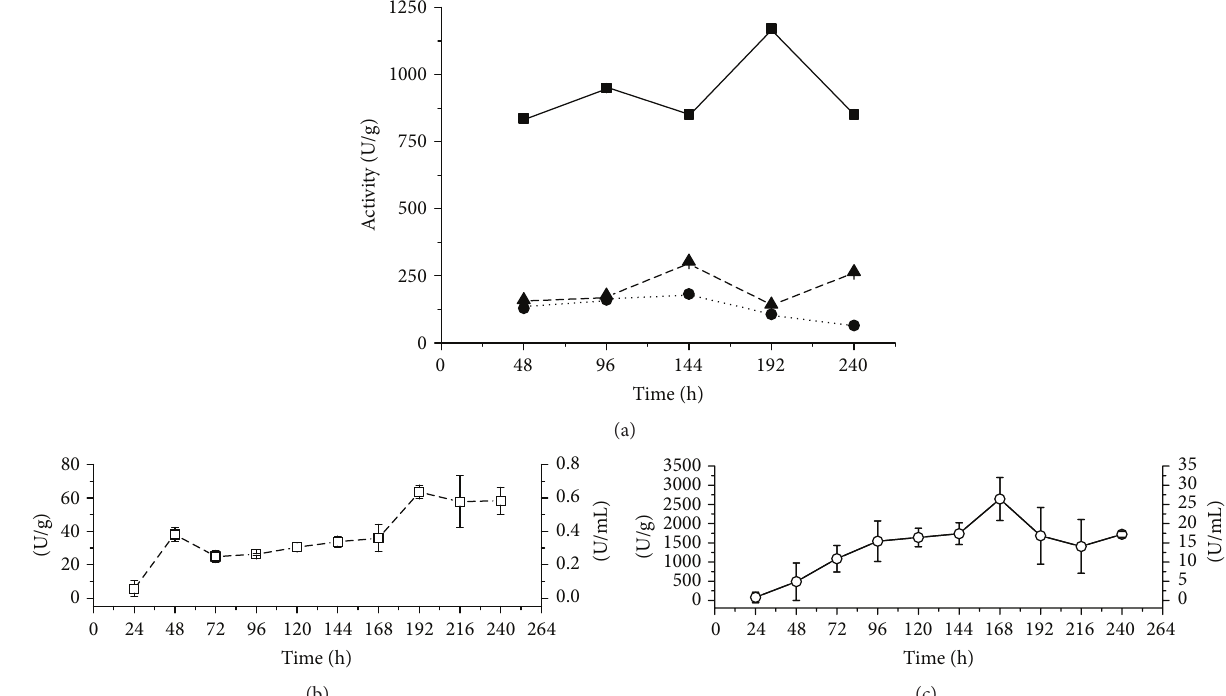
Figure 1: (a) Endoglucanase production (expressed as U/g) by M . heterothallica F.2.1.4. in solid-state cultivation. ( ◼ ) SSCWB; ( e ) SSCP; ( 󳵳 ) SSCLB. Endoglucanase production in submerged cultivation expressed as U/g and U/mL. (b) ( ◻ ) SmCWB; (c) ( I )